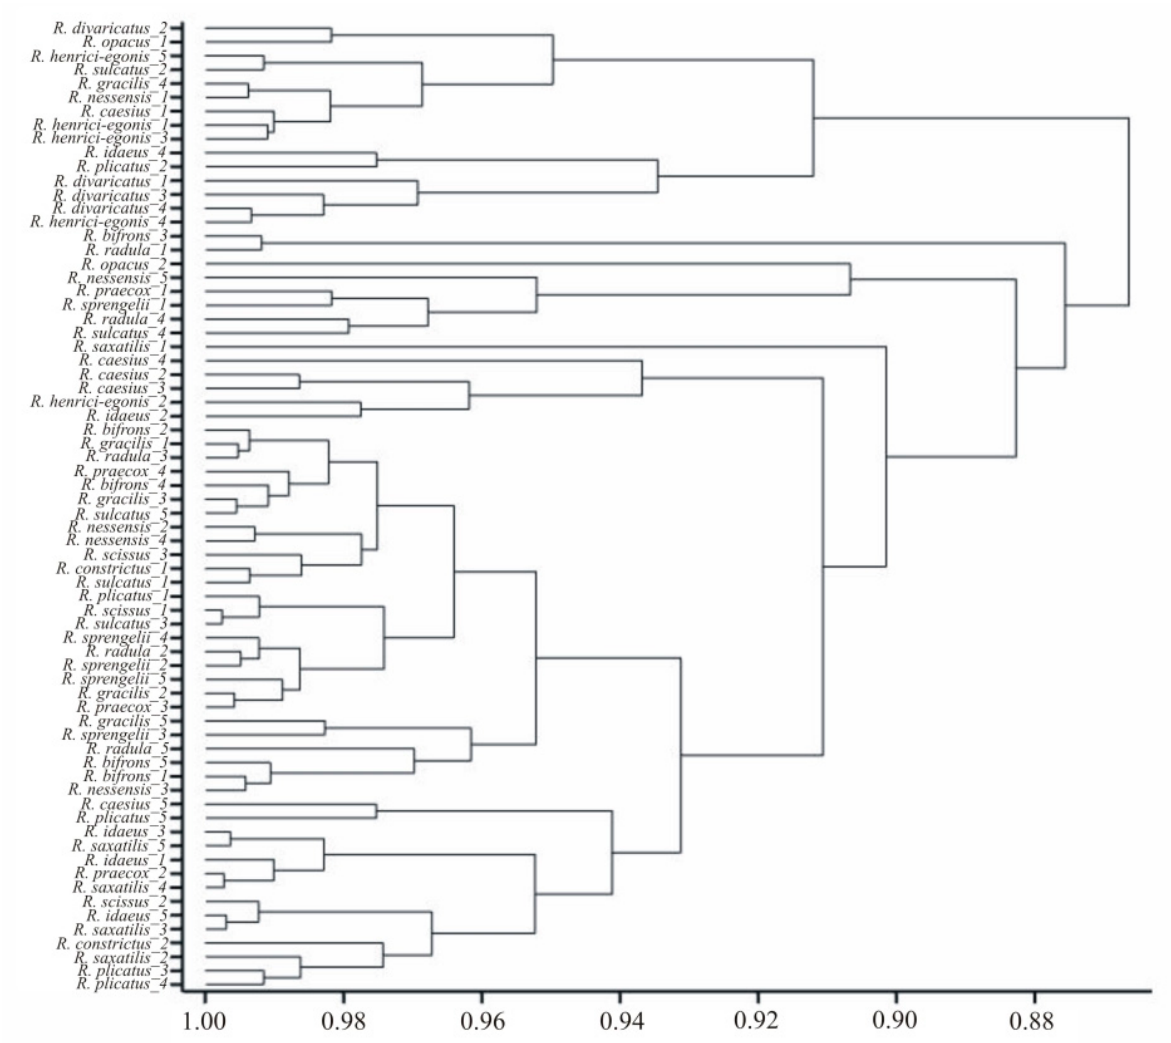
Figure 9. Clustering (neighbor joining method) of Rubus species based on nine morphological traits. The length of the lines indicates the similarity/distance between two species or among two groups of species and stated hierarchical clusters.